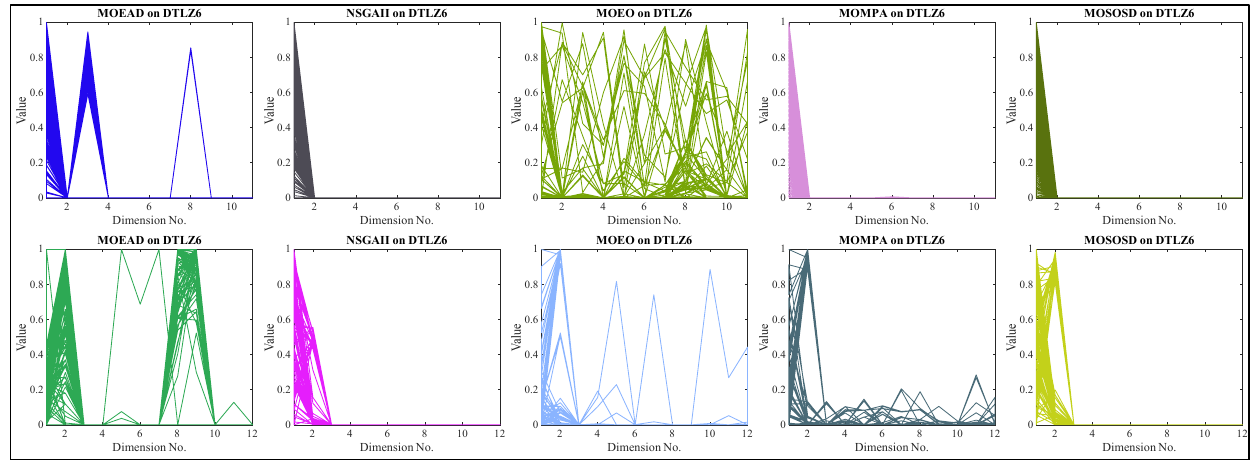
Figure 14. The dimension curve of MOEA/D, NSGA-II, MOEO, MOMPA, and MOSOS/D for DTLZ6 at M = 2, 3.